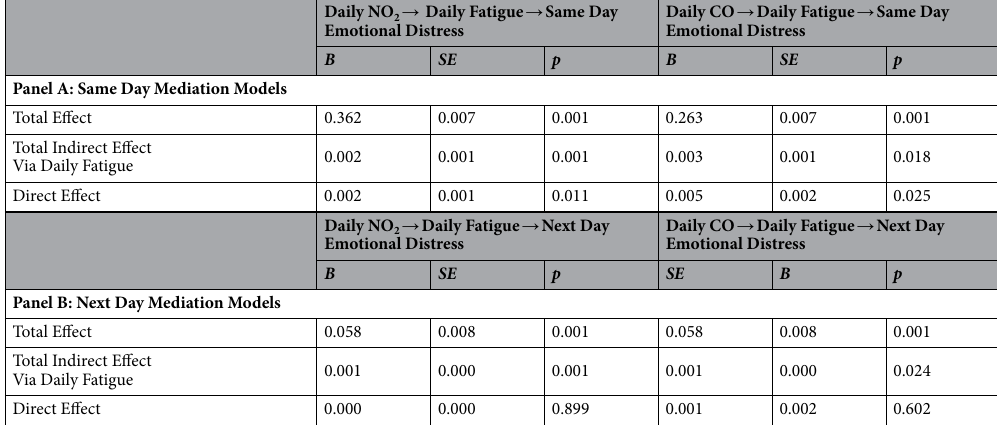
Table 2. Multilevel mediation results testing whether NO 2 and CO are related to emotional distress the same day (Panel A) and the next day (Panel B) via fatigue the same day, controlling for distress the same